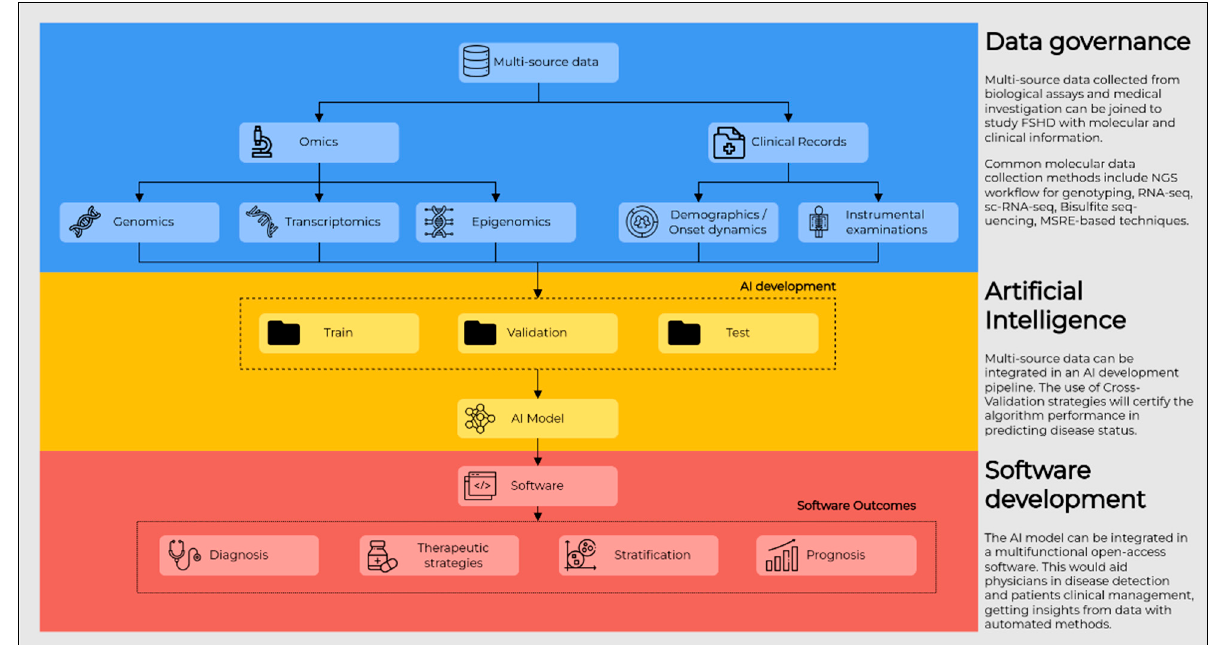
Figure 3. Schematic overview of a multifunctional tool. Such a tool would be able to integrate molecular, clinical and phenotype data with AI pipelines for enhancing the knowledge of FSHD and foster the research for novel treatment strategies, as well as biomarkers to be applied for the characterization, diagnosis, prognosis and monitoring of disease.